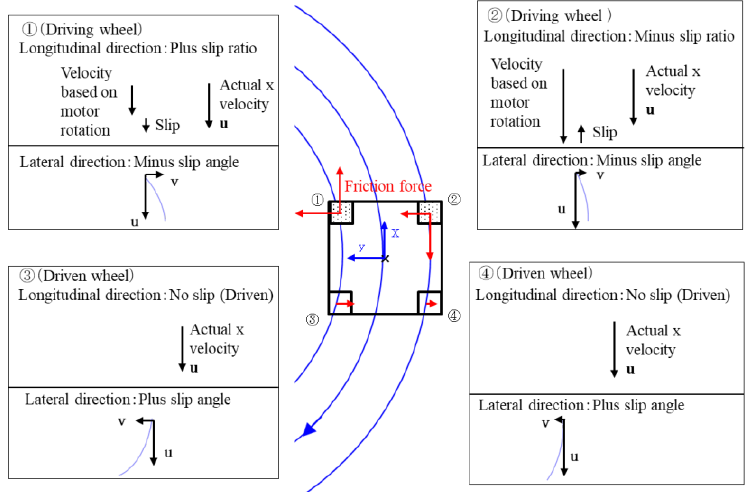
Figure 21. State of each wheel and friction force in backward movement. The red lines show the frictional forces acting on each wheel.